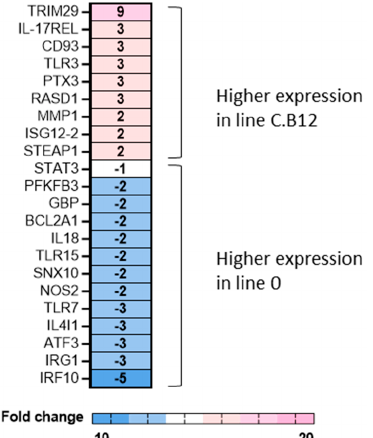
Figure 5. Hereditary differences in innate immune gene expression in lung macrophages from line C.B12 and line 0 chickens. Significant DEGs were identified by comparing the relative expression values, calculated through comparison to the maximum Cq for individual genes for lung macrophages from mock/untreated line C.B12 and line 0 chickens, with a significance level set at p < 0.05; fold change >1 (n = five per line). Heat map illustrates the mean fold change associated with significant DEGs between line C.B12 and line 0, and the fold change values are specific to line C.B12 (i.e., C.B12 v line 0). Fold change values are represented on a divergent, intensity colour scale showing the expression of upregulated genes (pink) to downregulated genes (blue).